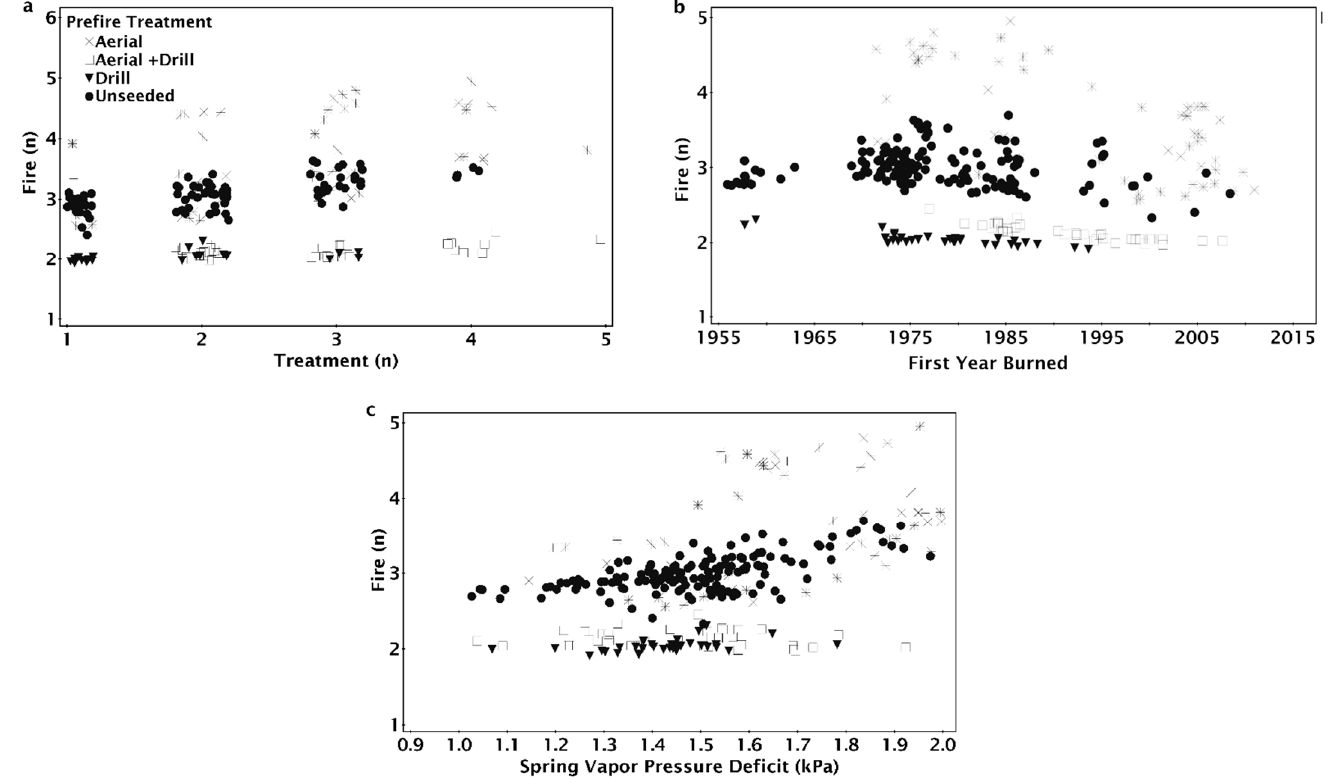
Figure 4. The modeled relationship between the number of fires grouped by the type of pre-fire seeding treatment (unseeded, aerial, drill, or both aerial and drill seeding) prior to the most recent fire along the gradient in ( a ) the minimum spring vapor pressure deficit (VPD), ( b ) the year the site first burned in a fire, and ( c ) the total number of seeding treatments (both aerial and drill seeding). Five percent jittering along the x-axis ( a ) or y-axis ( b , c ) was used to see overlapping treatments.